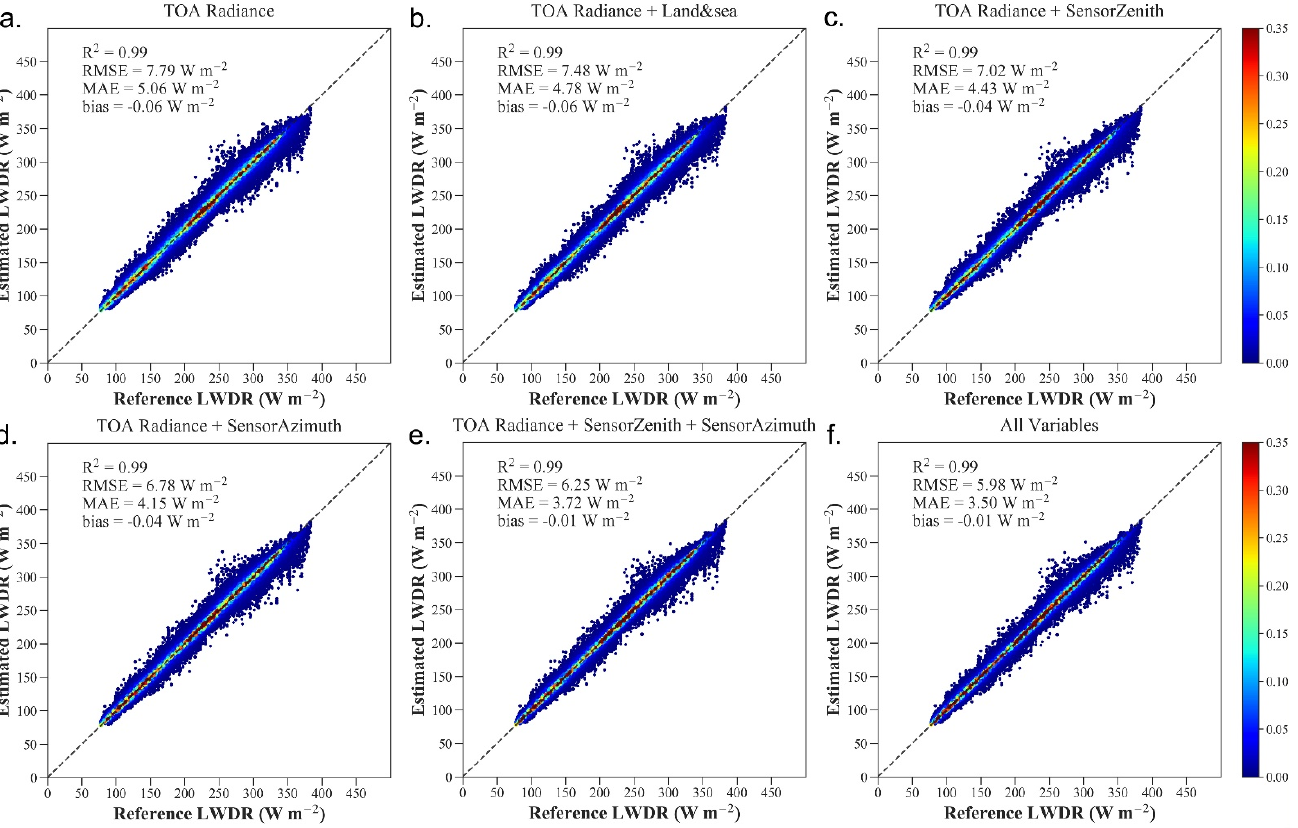
Figure 4. Evaluation of the ERT model prediction accuracy under different combination schemes of input variables. ( a − f ) indicates the specific scheme of input variables. The evaluation work was performed with the 20% reserved paired samples.